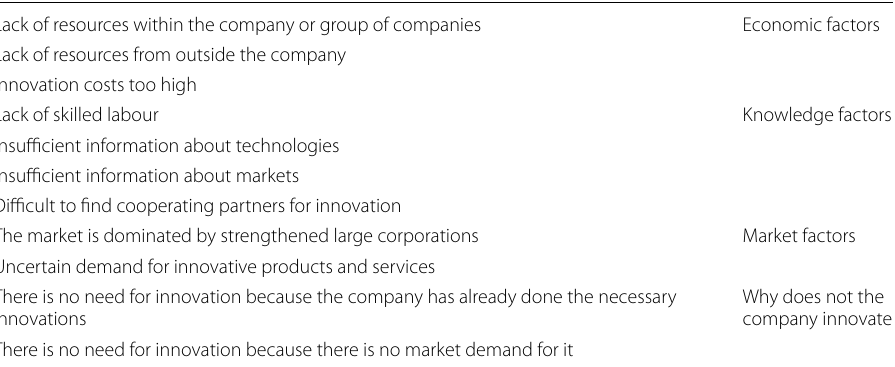
Source: Saatcioglu and Ozmen (2010)